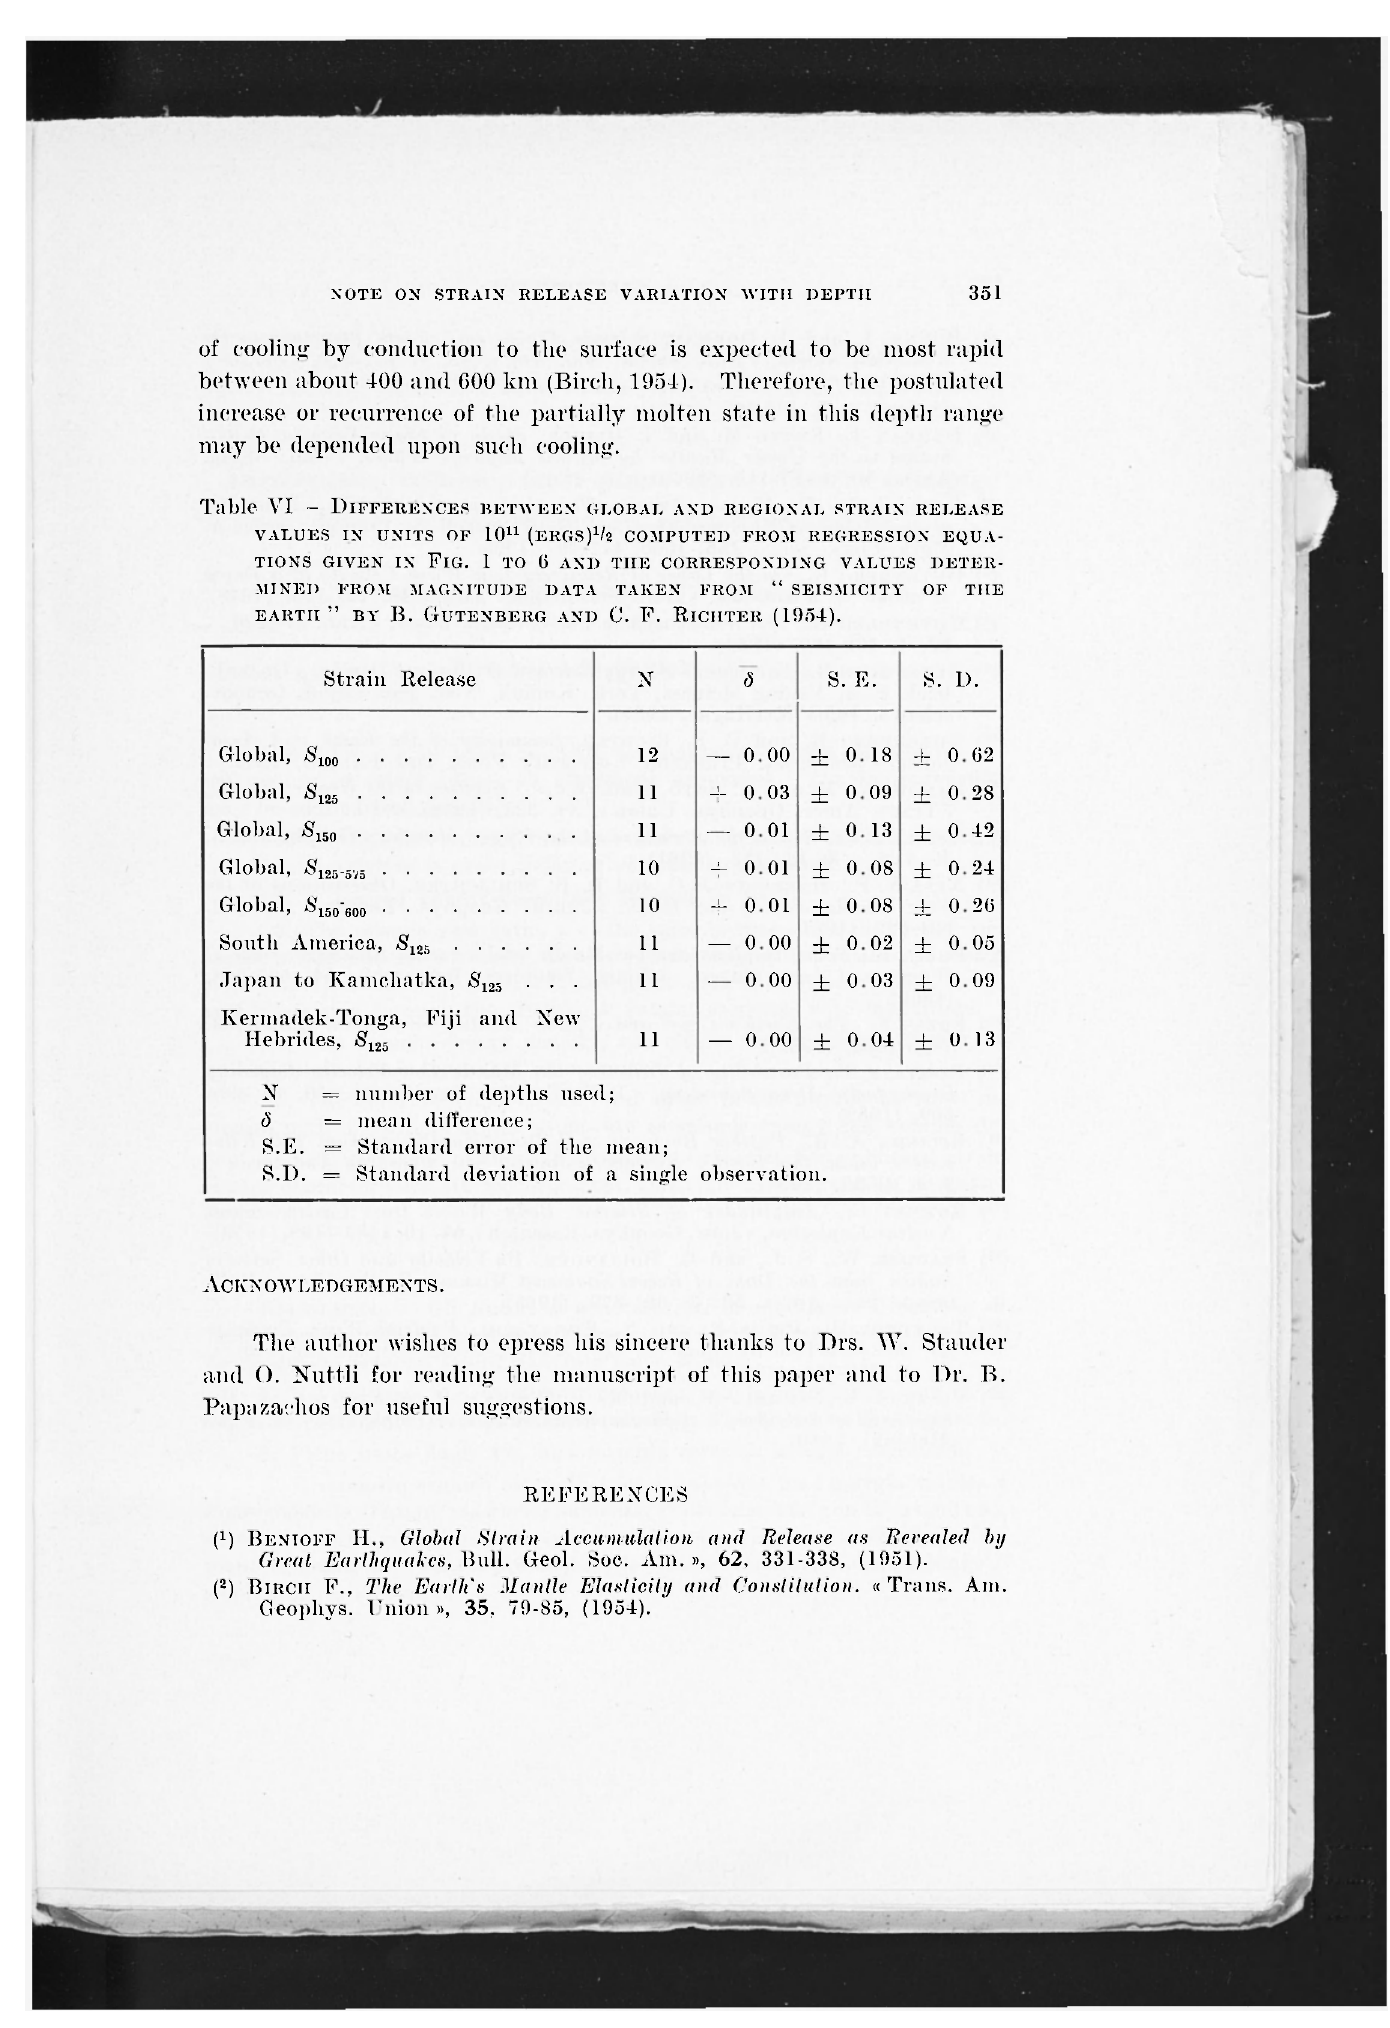
Table VI - DIFFERENCES BETWEEN GLOBAL AND REGIONAL STRAIN RELEASE VALUES IN UNITS OF 10 11 (ERGS)V2 COMPUTED FROM REGRESSION EQUA- TIONS GIVEN IN FIG. 1 TO 6 AND THE CORRESPONDING VALUES DETER- MINED FROM MAGNITUDE DATA TAKEN FROM " SEISMICITY OF THE EARTH " BY B. GUTENBERG AND C. F. RLCHTER (1954).